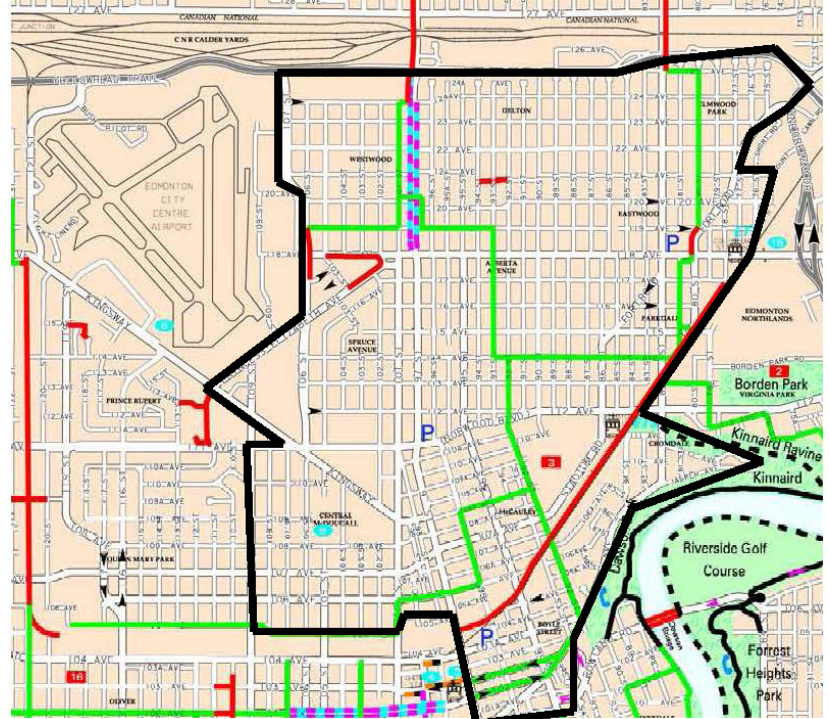
Figure 1. Study area for North Central Edmonton, Alberta.